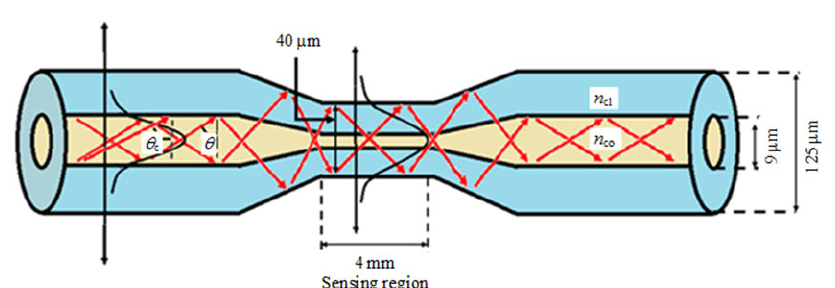
Fig. 1 Schematic of tapered optical fiber